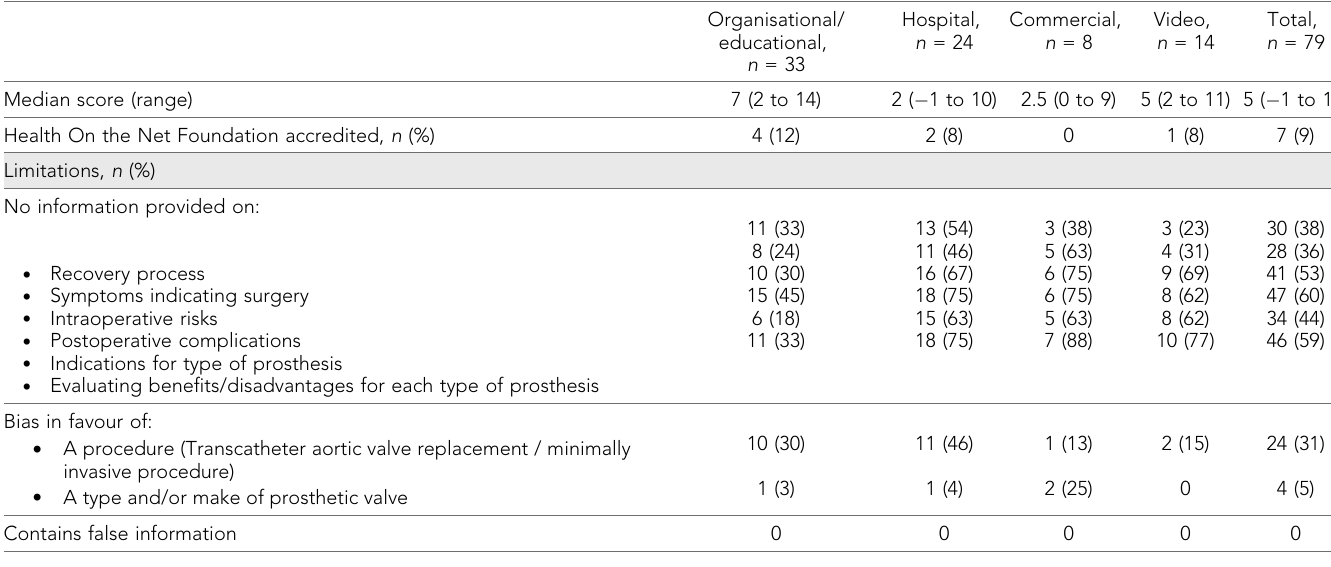
Table 2. Comparison by category of web